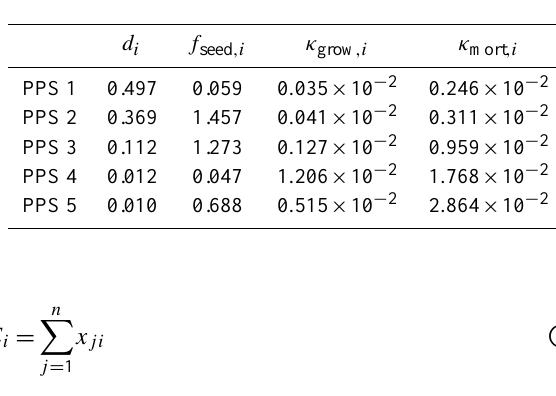
Table 2. Values of PPS characteristics calculated in DIVE from the output of JeDi: dominance d i , seed flux f seed ,i , growth rate κ grow ,i and mortality rate κ mort ,i .